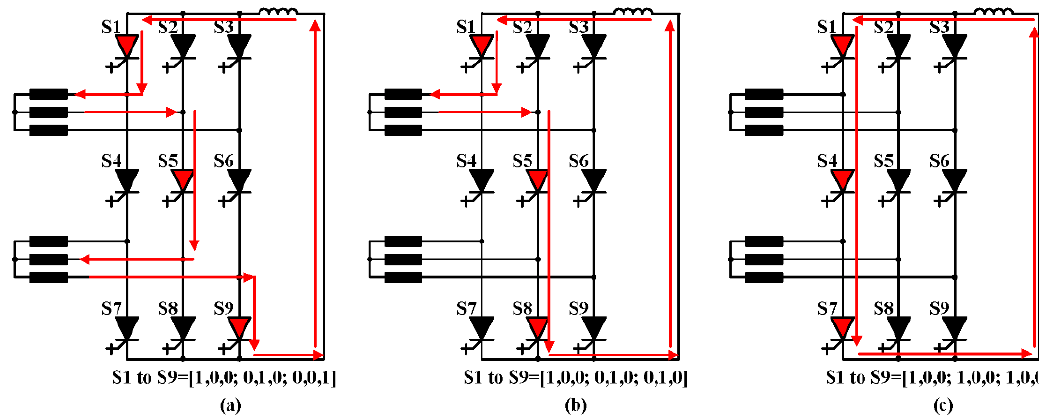
Figure 7. Current path of the converter with different switching states: ( a ) S1 to S9 is [1, 0, 0; 0, 1, 0; 0,